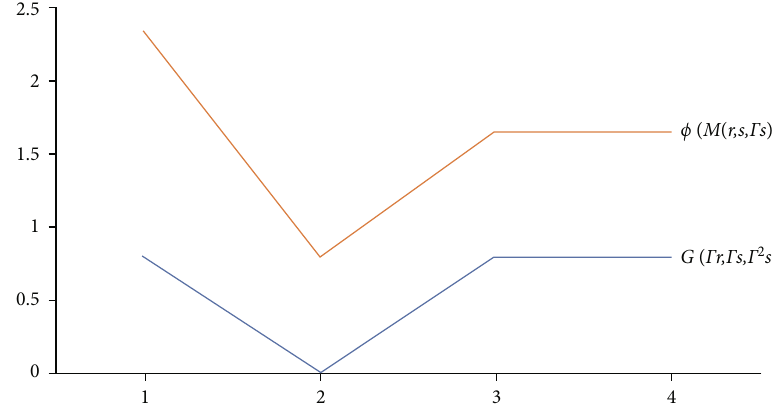
Figure 1: Illustration of contractive inequality (9) for all r , s ∈ f − 1, 1 g .